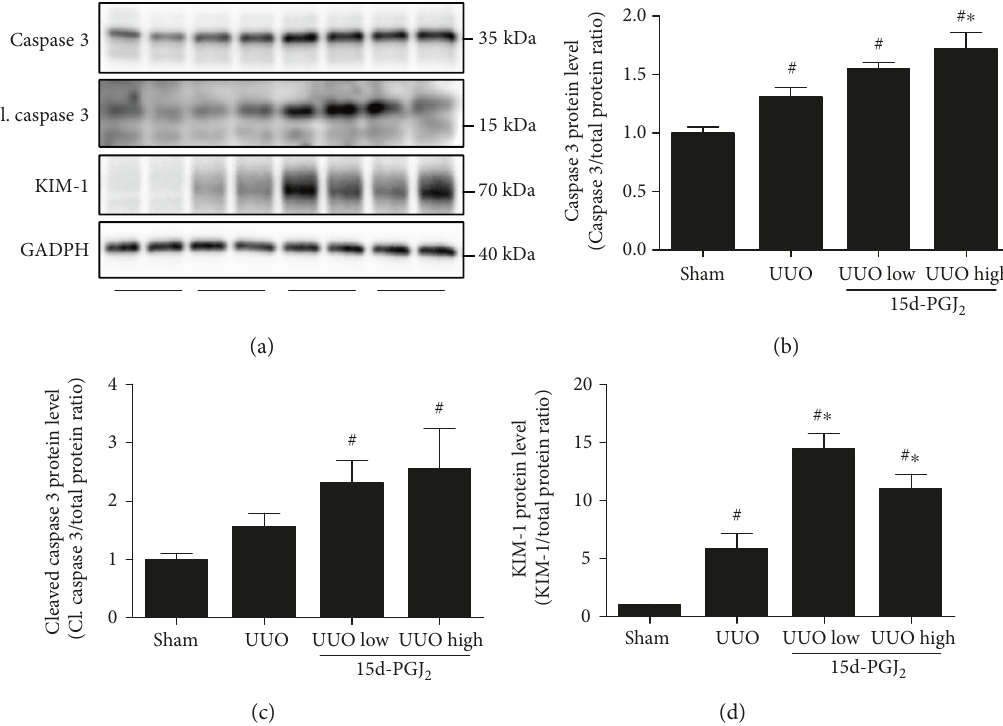
Figure 3: Cortical apoptosis and kidney injury are aggravated during UUO by treatment with 15d-PGJ Cleaved caspase 3 (Cl. caspase 3) protein expression. (c) KIM-1 protein expression. Representative blots are shown above each graph. 15d- PGJ was administered at a low (0.5 mg/kg/day) and a high (1 mg/kg/day) dose as depicted in each graph. Data represents mean ± SEM. 2 # P < 0 05 versus that in sham; ∗ P < 0 05 versus that in UUO, using ANOVA and Bonferroni ’ s post hoc tests ( n = 5 , sham; n = 6 , UUO